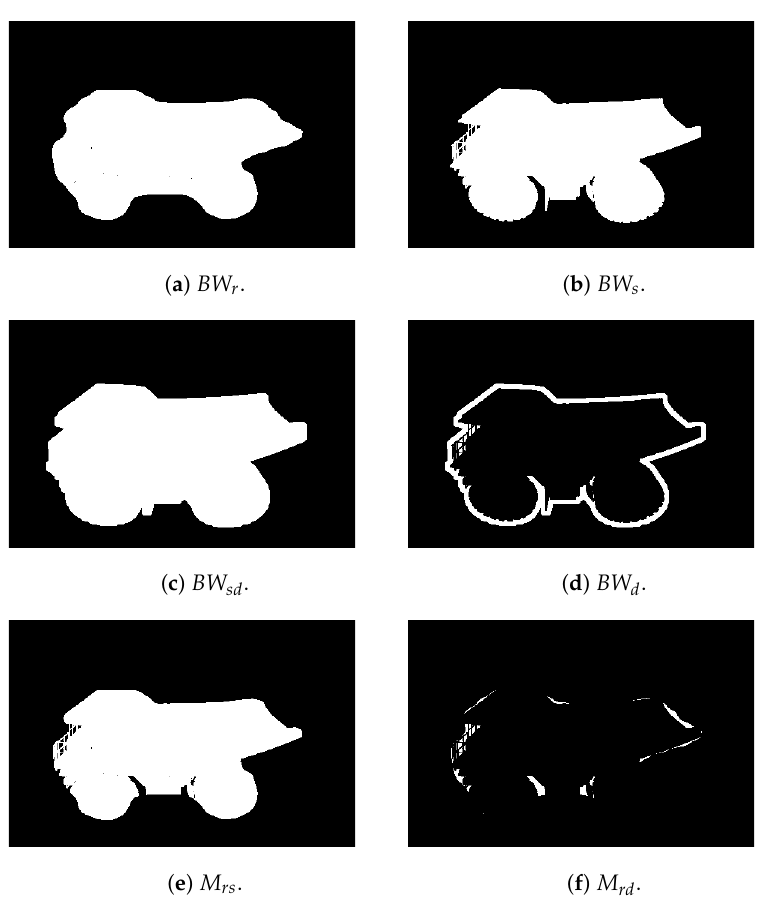
Figure 6. The images involved in the computation of the cost function term relative to the areas. ( a ) BW r , binary image of the real-world image. ( b ) BW s , binary image of the synthetic image. ( c ) BW sd , synthetic binary image dilated. ( d ) BW d , result of the subtraction between BW sd and BW s . ( e ) M rs , result of the multiplication between BW r and BW s . ( f ) M rd , result of the multiplication between BW r and BW d